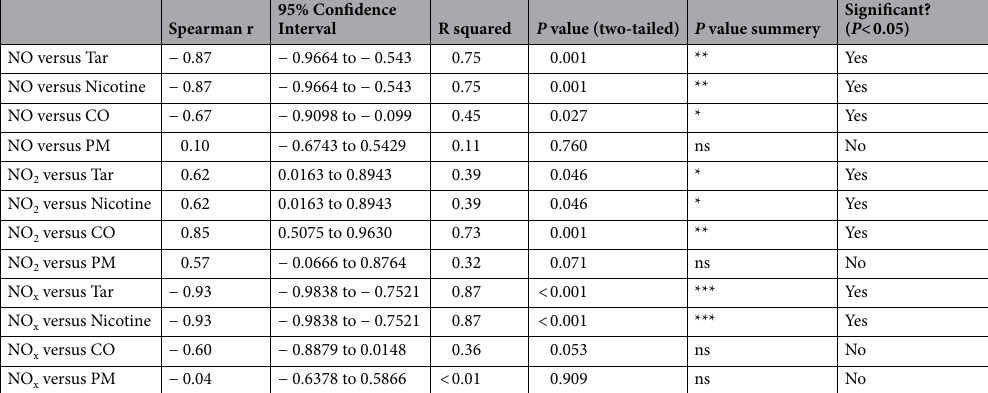
Table 3. Spearman correlations of the C mean values of NO, NO 2 , and NO x with concentrations of tar, nicotine, CO (as specified by the cigarette manufacturers), and PM 10 . P values show the significance of the correlations. ns = not significant ( P ≥ 0.05). * = significant ( P = 0.01 to 0.05). ** = very significant ( P = 0.001 to 0.01). *** = very significant ( P < 0.001).